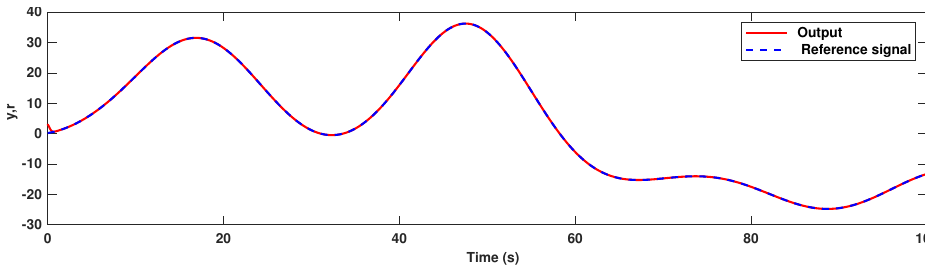
Figure 9. Example 2: The tracking